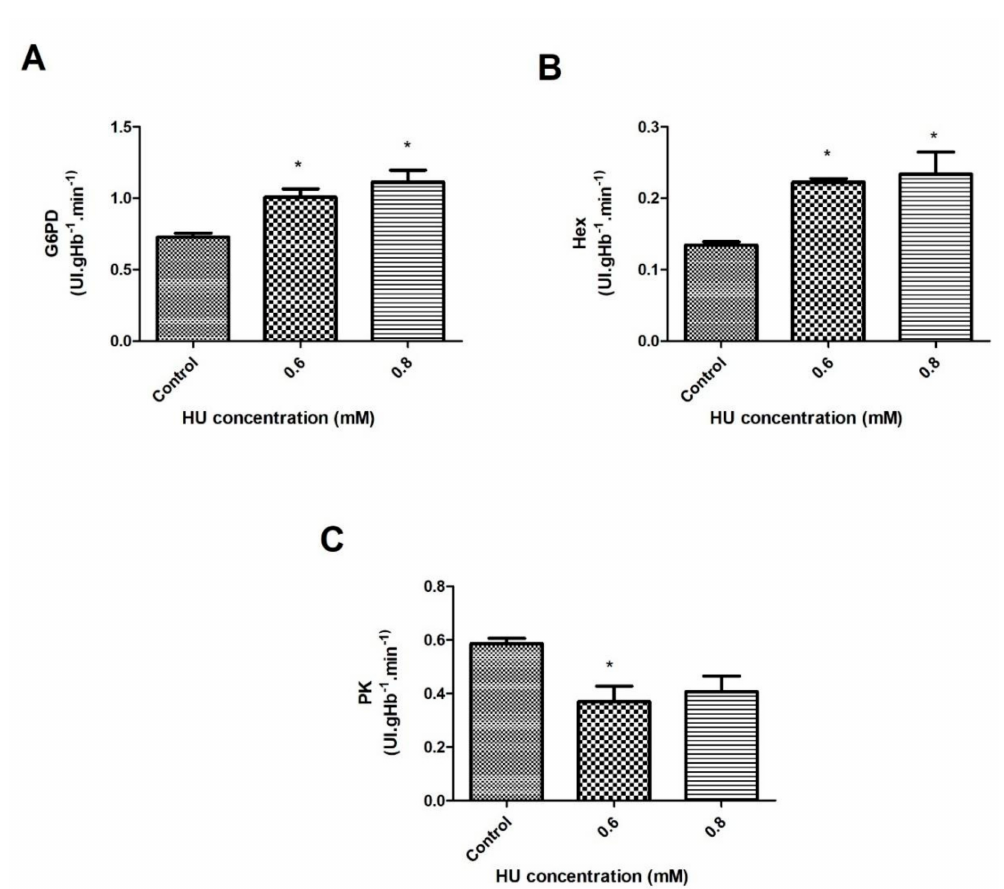
Figure 5. Enzymatic activity of the erythrocyte energy metabolism in the control samples that were treated with 0.6 and 0.8 mM HU ( n = 3) for 30 min. Hemolysate was used to measure ( A ) Glycose-6-phosphate-dehydrogenase (G6PD); ( B ) Hexokinase (Hex); ( C ) Pyruvate kinase (PK). In all of the cases, * represents a comparison between the control groups and the groups that were treated with HU (* p <